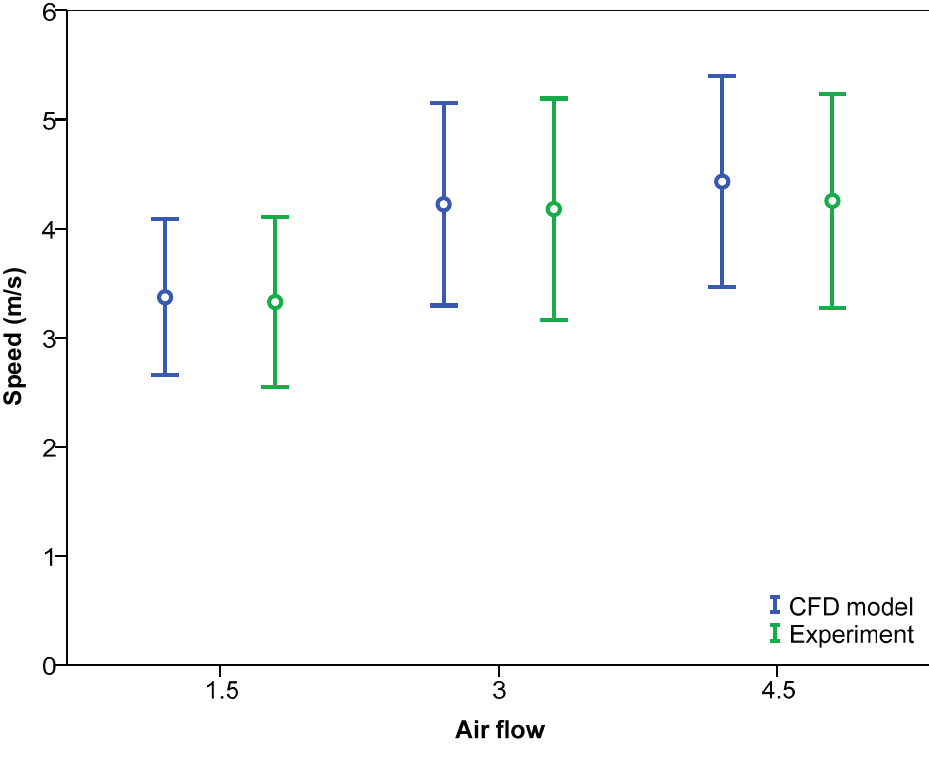
Figure 14. 95% confidence interval of means of air velocity values according to analysis type and air flow generated by